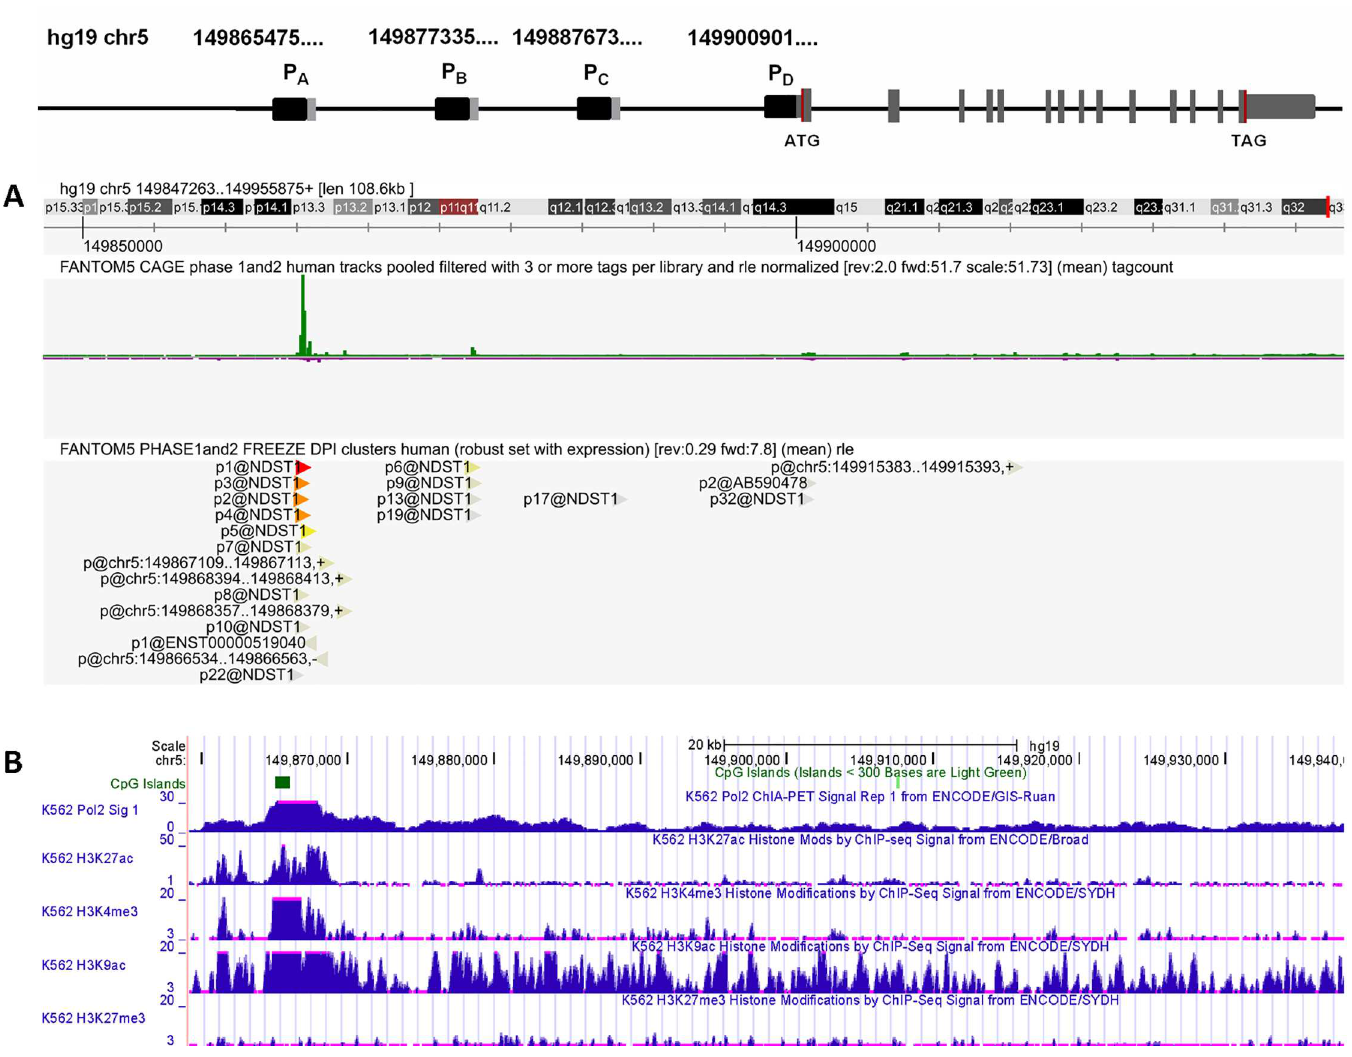
Fig 1. Schematic representation of NDST1 gene. The human NDST1 gene is located on chromosome5 and encompasses 15 exons. The first exon and a part of the second are untranslated regions. NDST1 contains four alternativetranscription starting sites indicatedas P A , P B , P C , and P D . (A) The parametric clusteringof CAGE sequences(green peaks) and DPI clusters (red and yellow arrows) indicates high tag expressionlevel for P A region. (B) Transcription associated features such as CpG island, Pol II bindingsite and histone methylation/acetylation profile identifiesP A region as the most usablepromoter for NDST1 gene transcription. Data is filtered for K562 cell line. Screenshots for NDST1 promoter analysiswere obtained from ZENBU genome browser (FANTOM5 Project) (http://fantom.gsc.riken.jp/zenbu/) and from UCSC Genome Database browser (http://genome.ucsc.edu/) using Human Feb. 2009 (GRCh37/hg19)